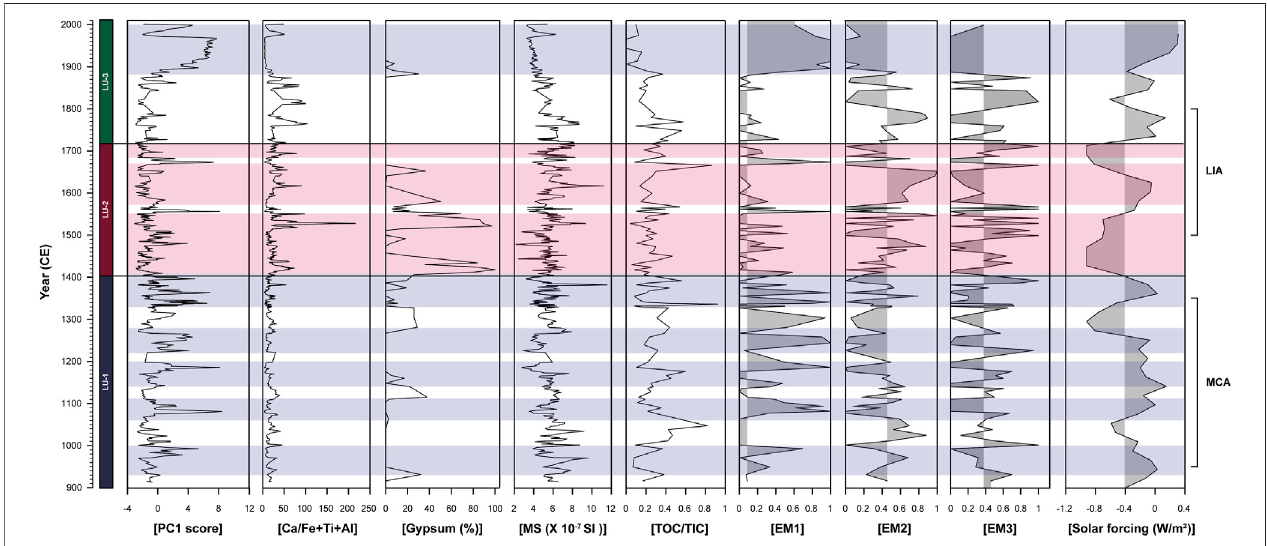
FIGURE 9 | Multiproxy data obtained from Gayal el Bazal from 900 CE to 2000 CE showing three units (marked by blue and red stripes) indicating wet and dry intervals, respectively (Steinhilber et al., 2012).